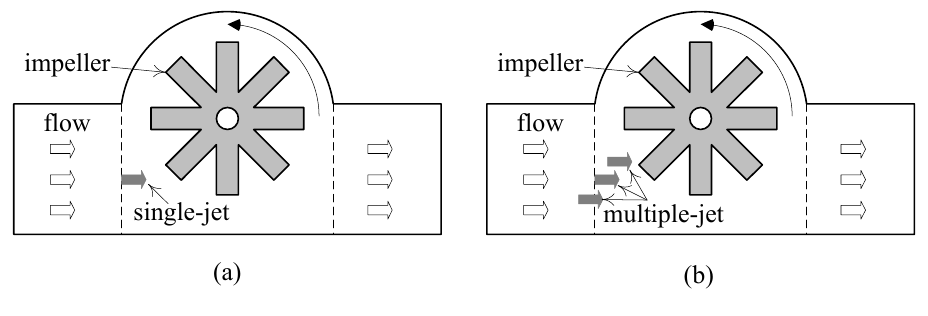
Figure 1. ( a ) single jet meters; ( b ) multiple jet